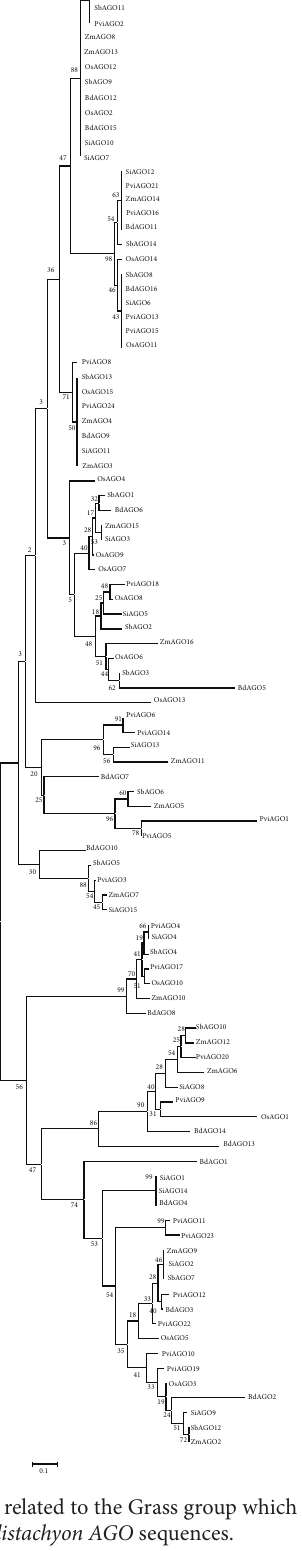
Figure 3: Phylogenetic tree of the Argonaute protein related to the Grass group which consists of Sorghum bicolor, Zea may, Setaria italica, Panicum virgatum, Oryza sativa, and Brachypodium distachyon AGO